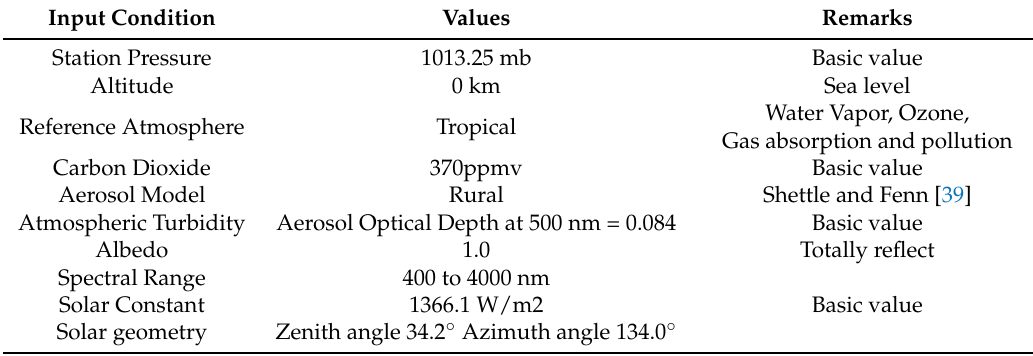
Table 2. Input parameters of an atmospheric layer for run SMARTS, version 2.9.5. The output parameters are direct and diffuse horizontal irradiance. Simulable spectral range is 280 to 4000